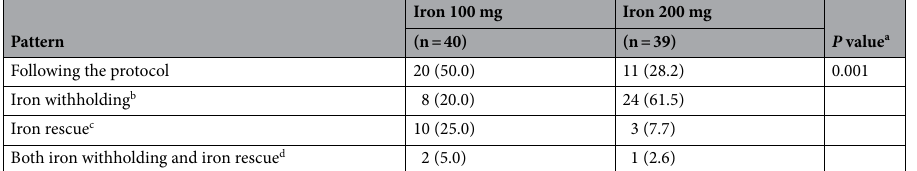
Table 3. Protocol compliance of intravenous iron regimens. Data are presented as number (percent). Percentages may not total 100 due to rounding. TSAT, transferrin saturation. a Exact probability test was used to calculate the P value. b Iron withholding if ferritin > 700 ng/dl or TSAT > 40%. c Iron rescue (total dose of 1 g) in patients with iron deficiency (ferritin < 200 ng/dl or TSAT < 20%). d Iron withholding and iron rescue events occurred in the same